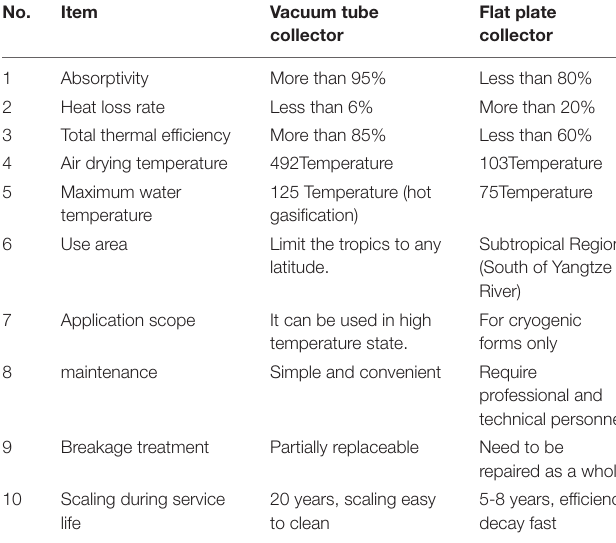
TABLE 2 | Performance comparison base on pros and cons between vacuum tube collector and flat plate collector. 3